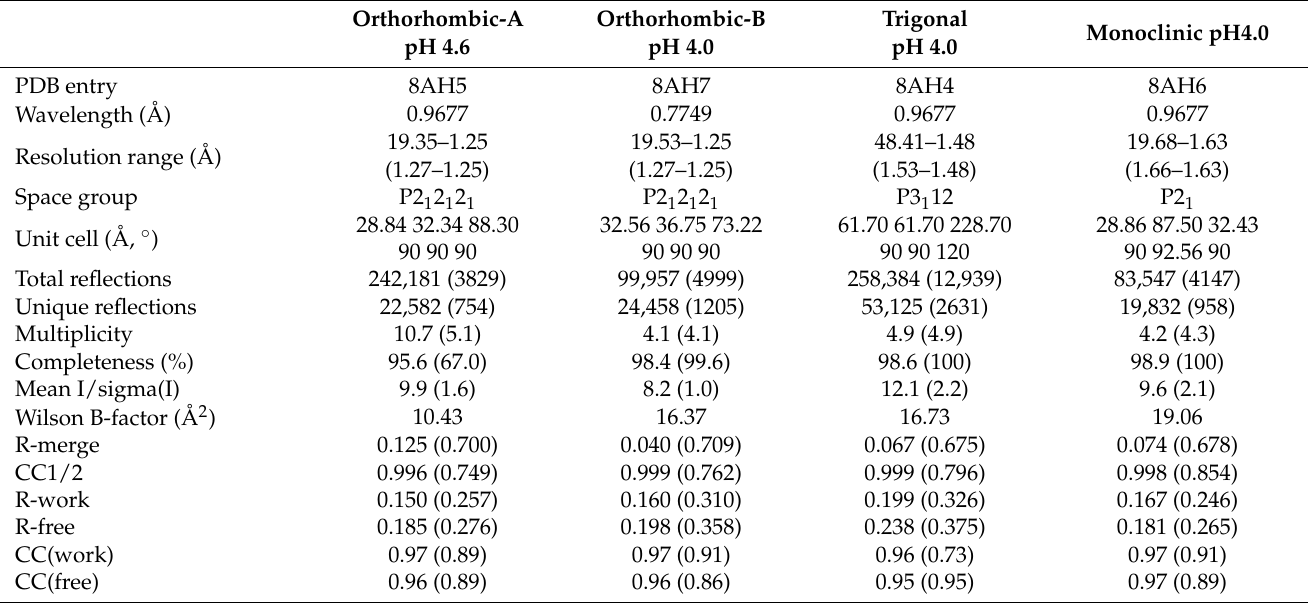
Table 1. Data collection and refinement